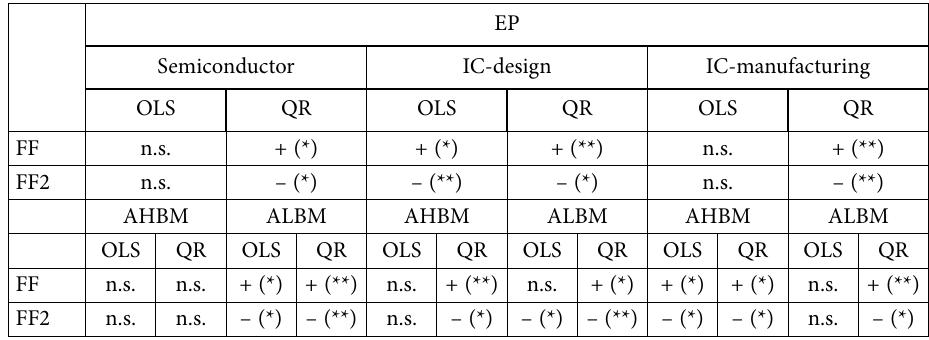
Table 11. Consolidated consequences